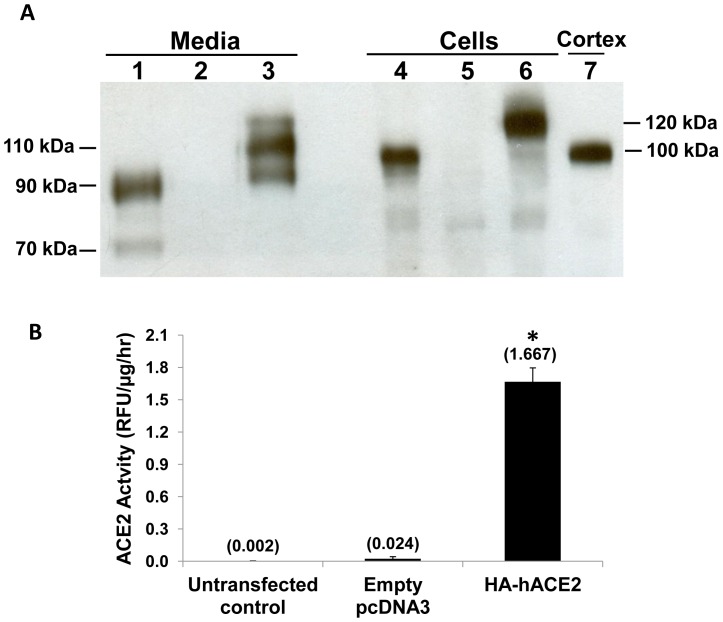
Immunoblot analysis of ACE2 protein in media and cell lysates from mouse PT cells.(A) Representative immunoblot for ACE2 protein in concentrated media (Lanes 1–3) and cell lysates (Lanes 4–6) from mouse PT cells. Lanes 1 and 4: wildtype cells, Lanes 2 and 5: ACE2 knockout (KO) cells, Lanes 3 and 6: ACE2 KO cells transfected with a human ACE2 expression vector, Lane 7: mouse kidney cortex showing a band at ∼100 kDa, used as a positive control. Lane 1 shows two bands in the media at ∼90 kDa and ∼70 kDa for mouse ACE2. Lane 3 shows two bands in the media for human ACE2 in transfected cells, at ∼110 kDa and ∼95 kDa. Lanes 4 and 6 show a single band in cell lysates at ∼100 kDa for mouse ACE2, and ∼120 kDa for human ACE2, respectively. Lanes 2 and 5 show no ACE2 bands detected on immunoblots of both media and cell lysates from untransfected ACE2 KO cells. (B) Increased ACE2 activity in the media from ACE2 KO cells transfected with a human ACE2 expression vector (HA-hACE2, 3.75 µg on 35 mm culture dishes). Untransfected cells and cells transfected with an empty pcDNA3 vector had no detectable ACE2 activity in the media. Numbers in parentheses represent mean values for ACE2 activity. *P<0.001 vs untransfected control or empty pcDNA3 vector, n = 4.